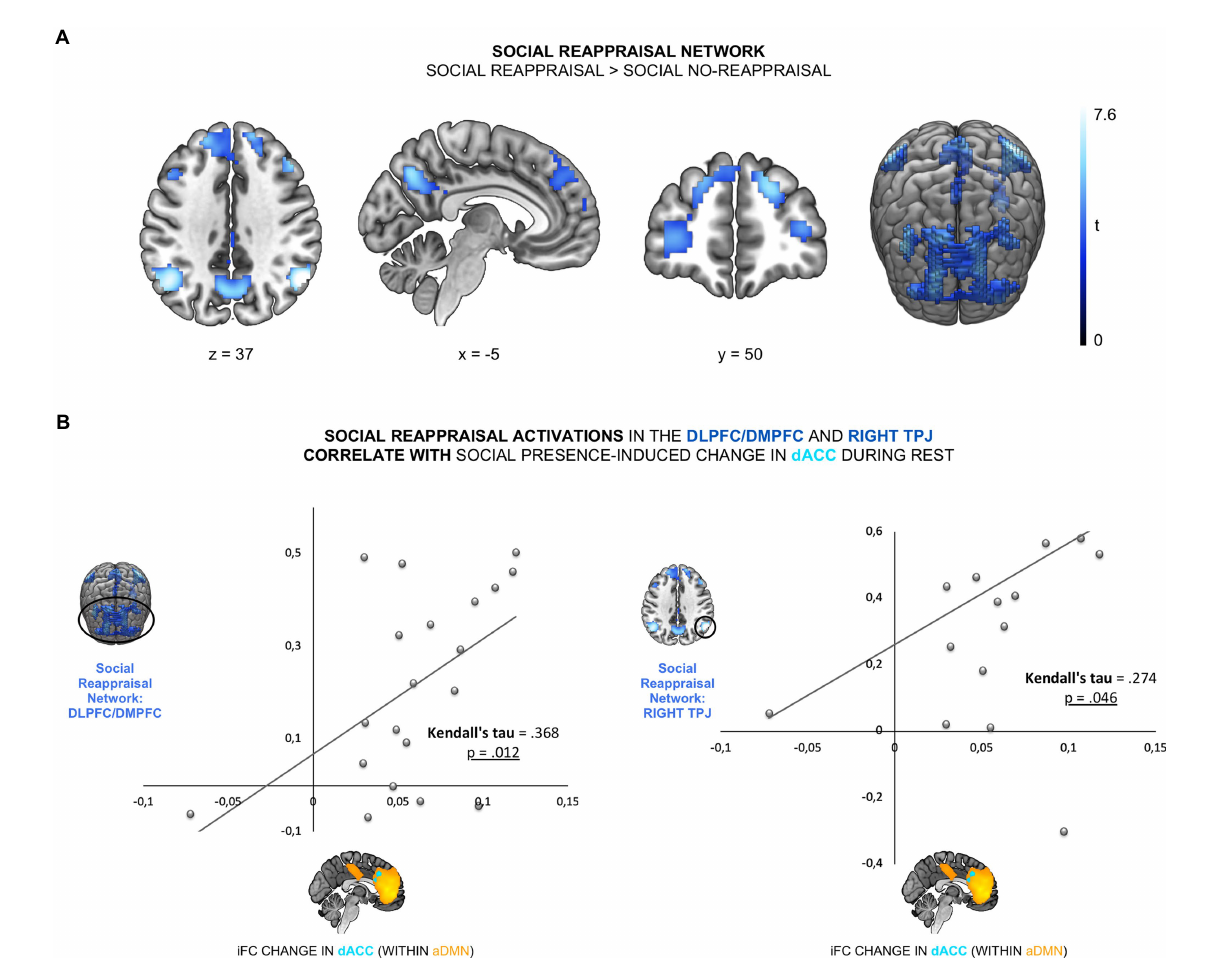
FIGURE 3 The social presence-related effect in the aDMN was linked to social reappraisal-related brain activations. (A) The social reappraisal network was derived from the contrast social reappraisal > social no-reappraisal during negative picture viewing of the social reappraisal task, whole-brain FWE-corrected ( p < 0.05) at the cluster levels, based on a height threshold of 0.005. (B) The social presence-related change in the dACC was correlated with the social reappraisal-related activation changes in the DLPFC/DMPFC (Kendall’s tau = 0.368, p = 0.012) and right TPJ (Kendall’s tau = 0.274, p =